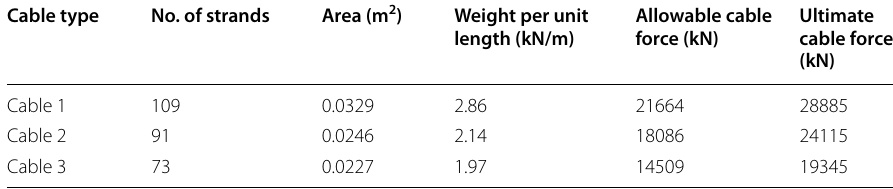
Table 2 Properties of the cables Cable type